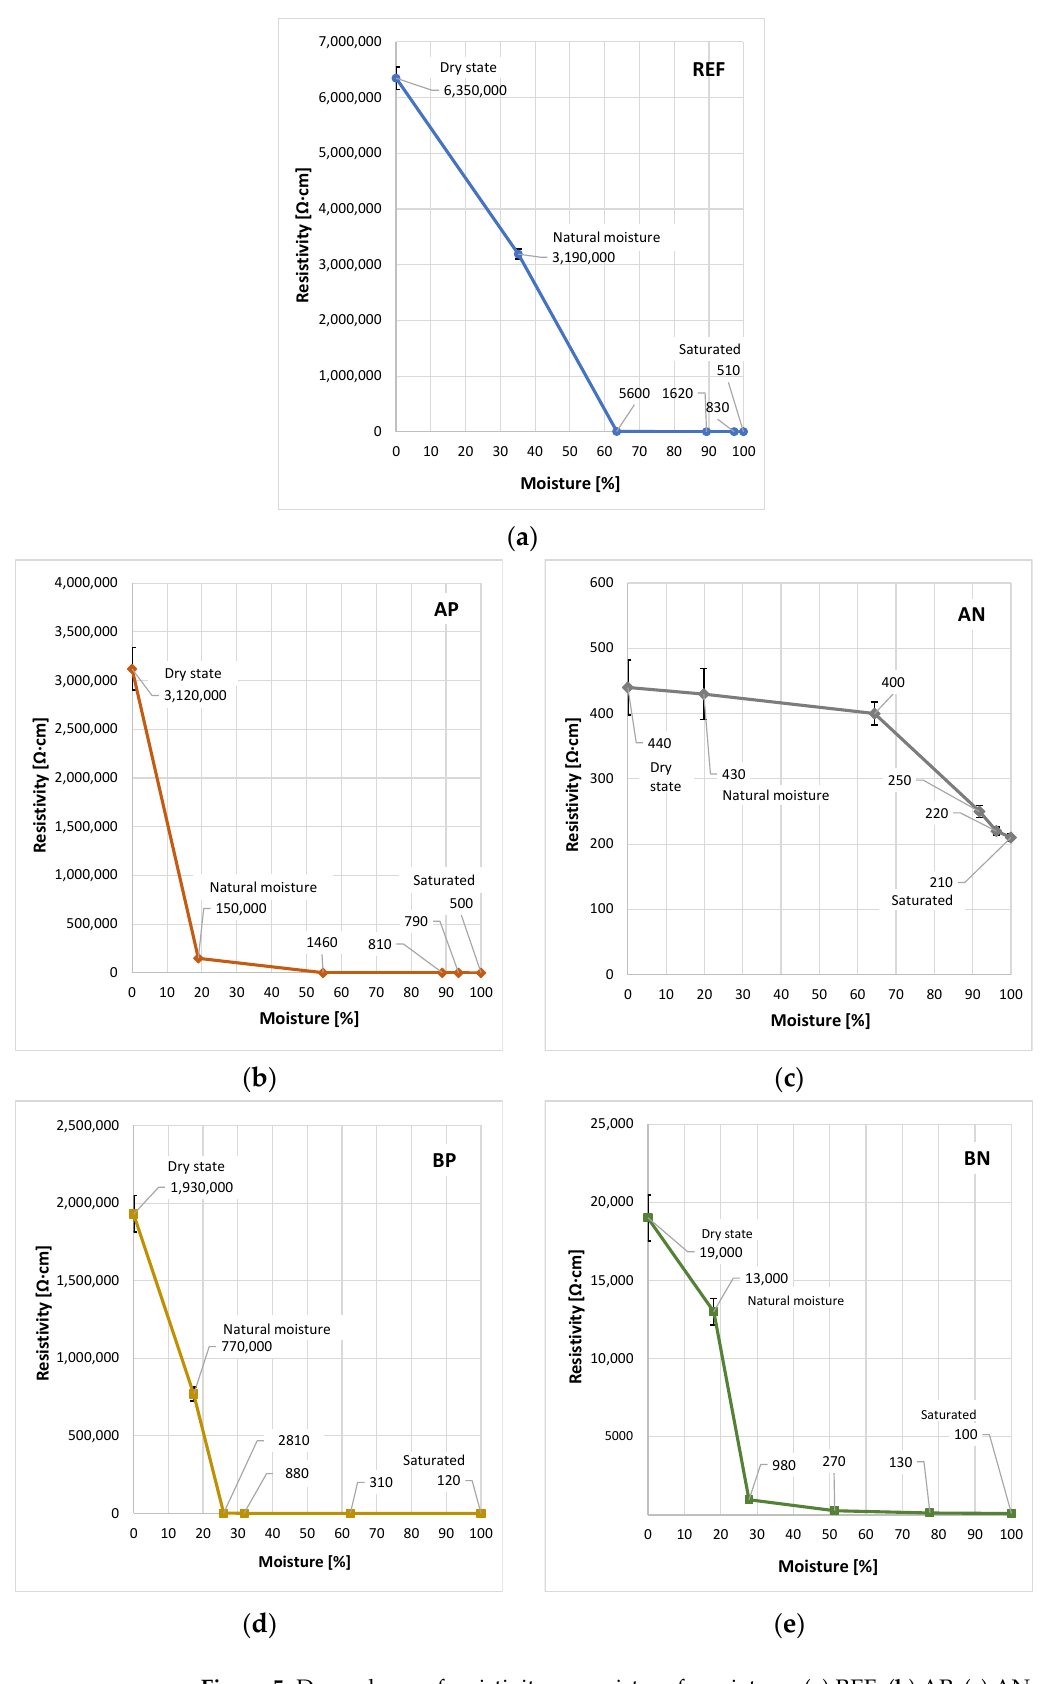
Figure 5. Dependence of resistivity on moisture for mixtures ( a ) REF; ( b ) AP; ( c ) AN; ( d ) BP; ( e ) BN.